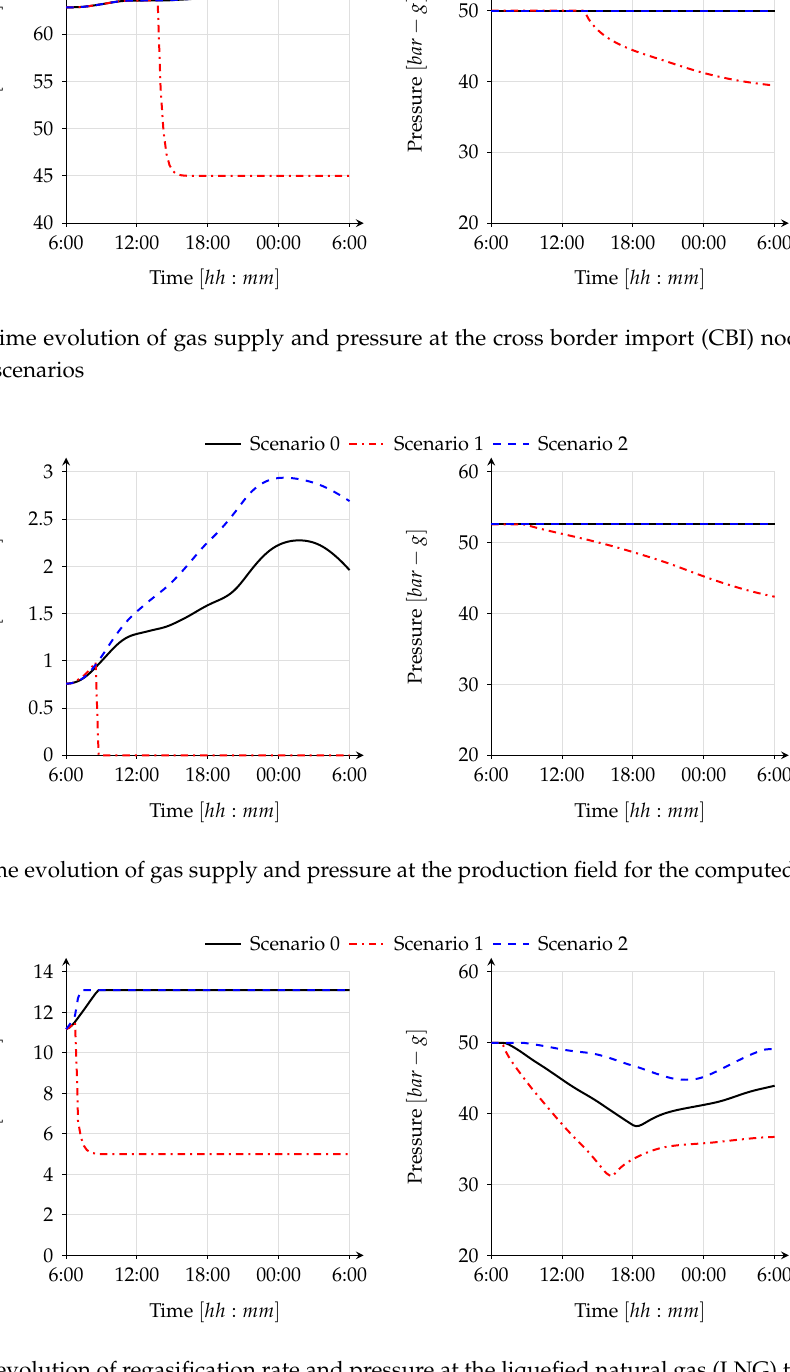
Figure 10. Time evolution of regasification rate and pressure at the liquefied natural gas (LNG) terminal for the computed